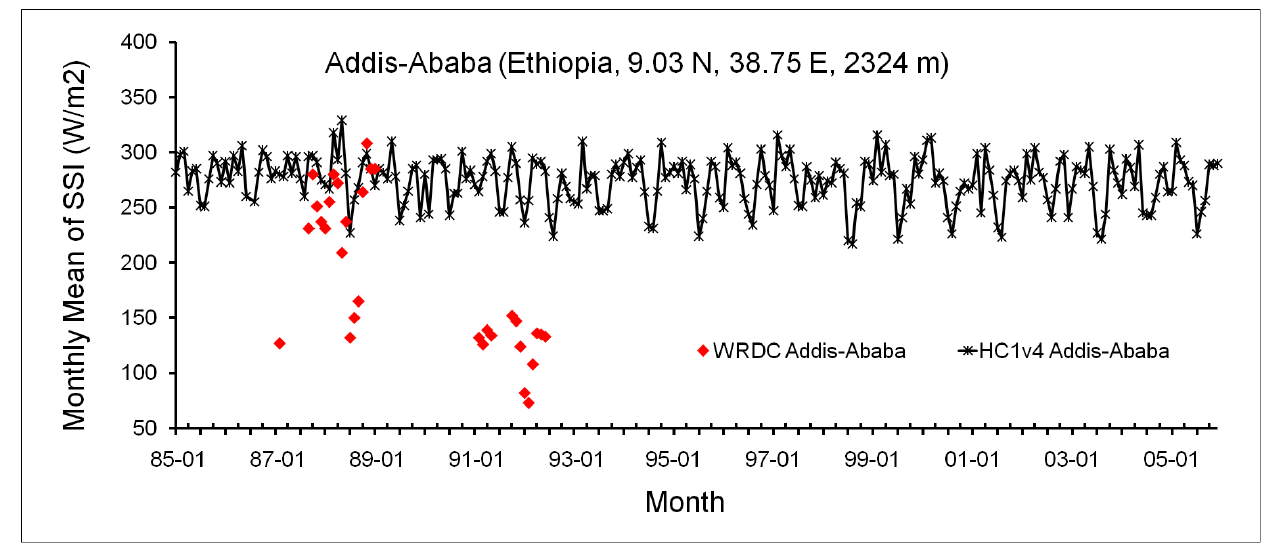
Figure 3. Monthly means of SSI from HC-1 in Addis-Ababa during the period 1985–2005 and comparison with the available ground-based measurements (WRDC).